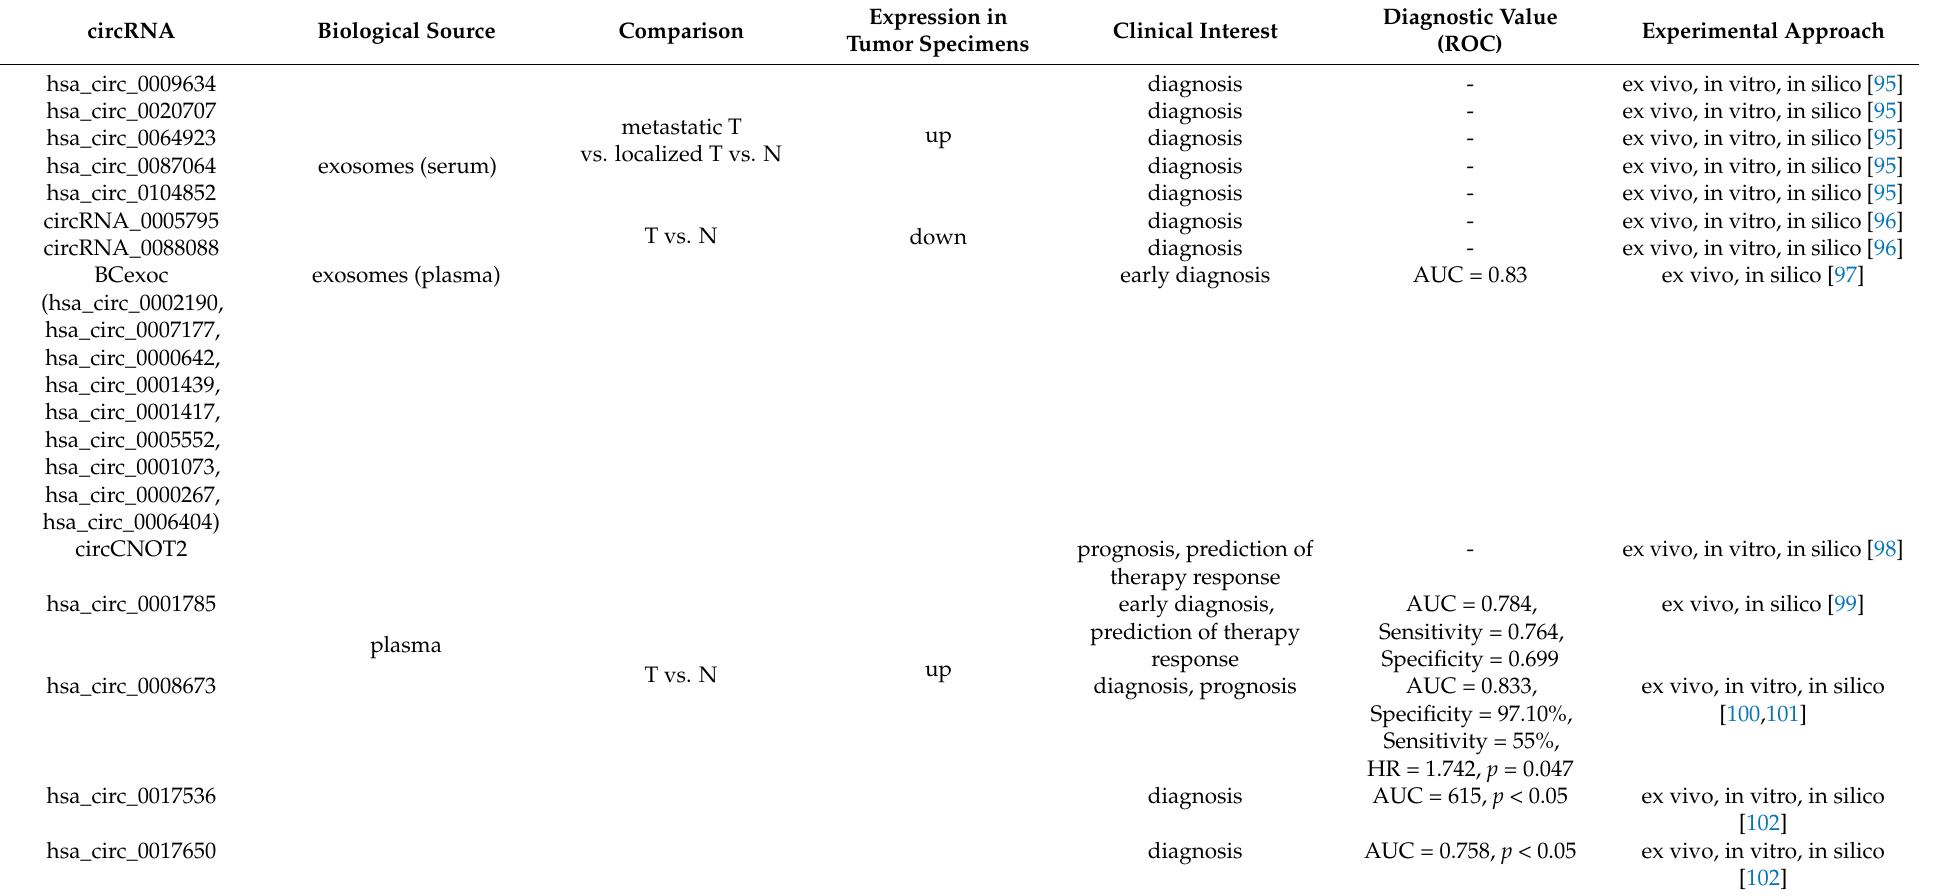
Table 2. List of circulating circRNAs reported as potential biomarkers in breast